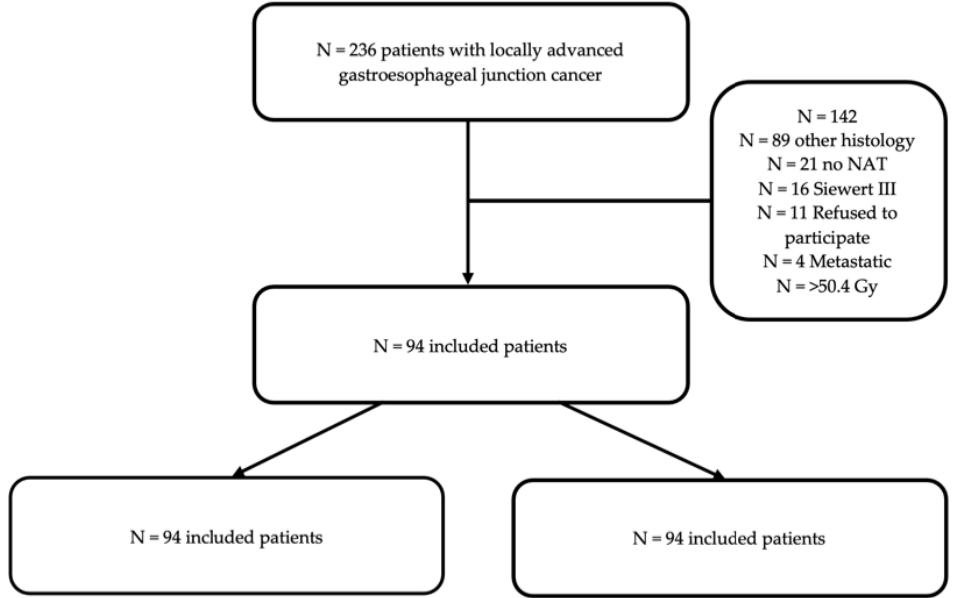
Figure 1. Flowchart of the study description of the patient inclusion in the study group for analysis. Table 1. Demographic and preoperative characteristics of the study population.